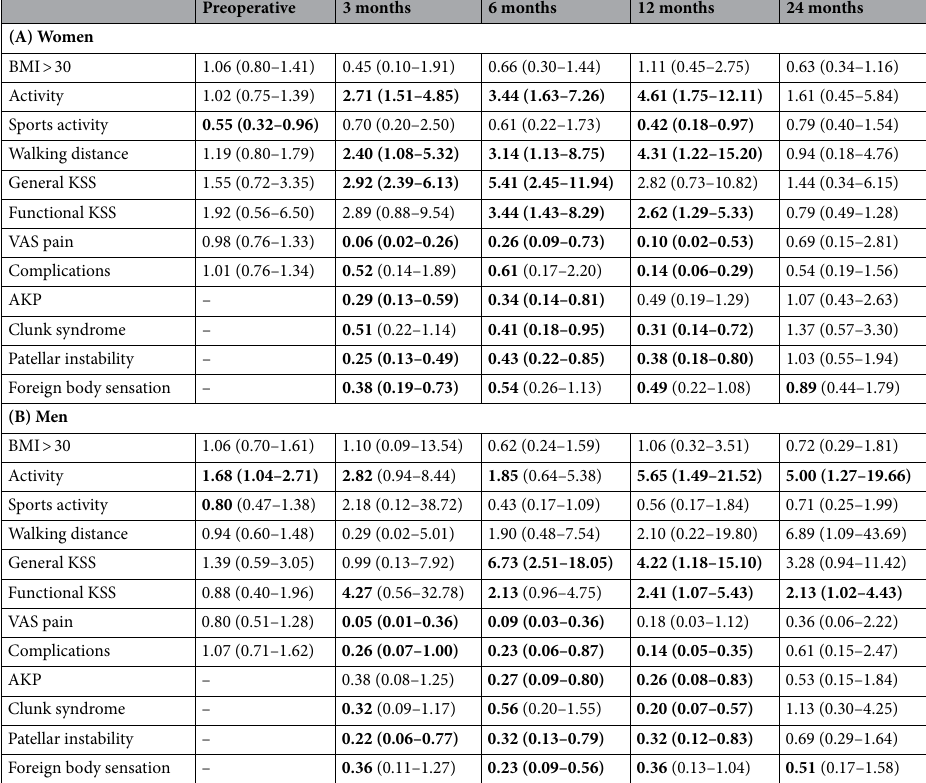
Table 2. Contribution of the studied factors to overall postoperative satisfaction within 2 years of TKA in (A) women and (B) men at particular check-ups. Values represent odds ratios (OR; 95%CI, low–high value). OR values above 1 are associated with satisfaction; values below 1 are associated with not being fully satisfied. Values with ORs associated with satisfaction at particular check-ups are marked in bold. Despite larger CIs resulting from greater data diversity or fewer patients per check-up examination, time-dependent trends for analysed factors are evident (in